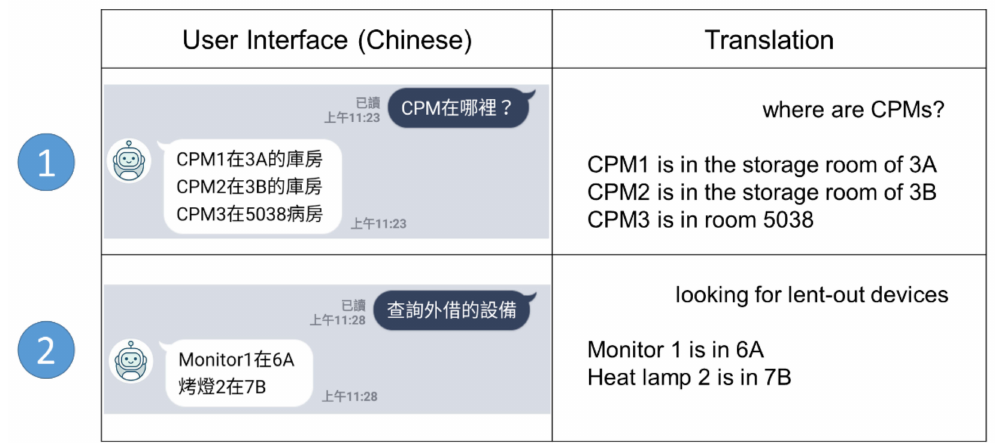
Figure 1. Dialog-based object query system (DBOS) user interface.